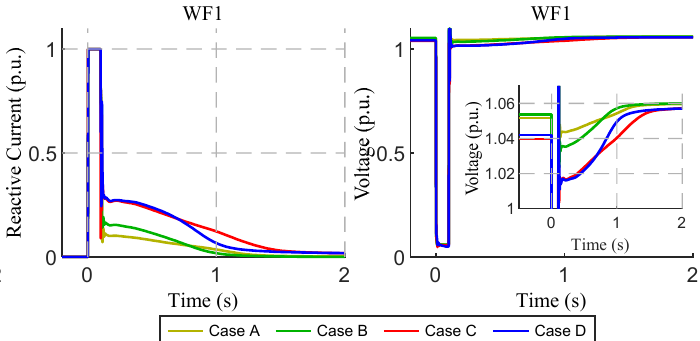
Figure 24. BESS power converter synthetic frequency and terminal voltage with different IM load percentages.